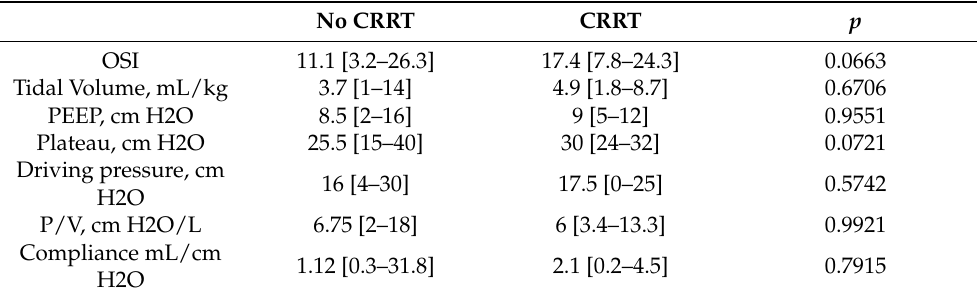
Table 3. The ventilator parameters characterizing the severity of ARDS showed no significant difference.